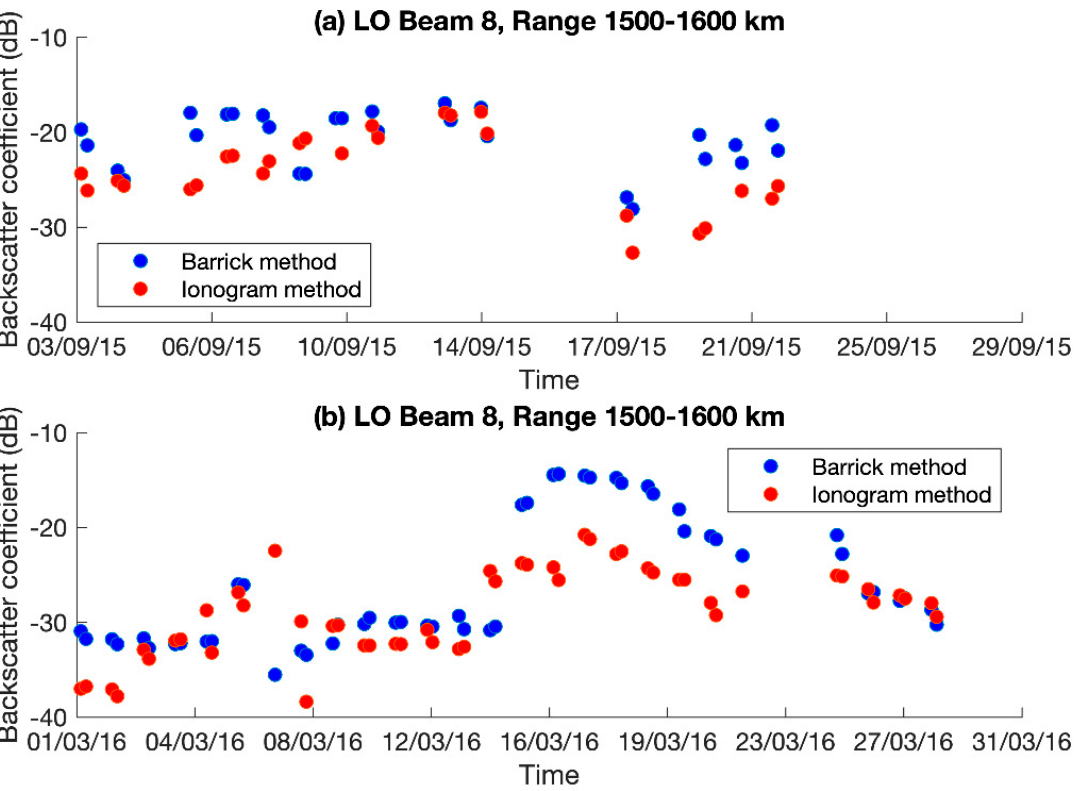
Figure 7. Backscatter coefficients calculated via the Barrick method (blue) and the backscatter ionogram method (red) for a single location (Longreach beam 8, at a range of 1500–1600 km) throughout ( a ) September 2015 and ( b ) March 2016.